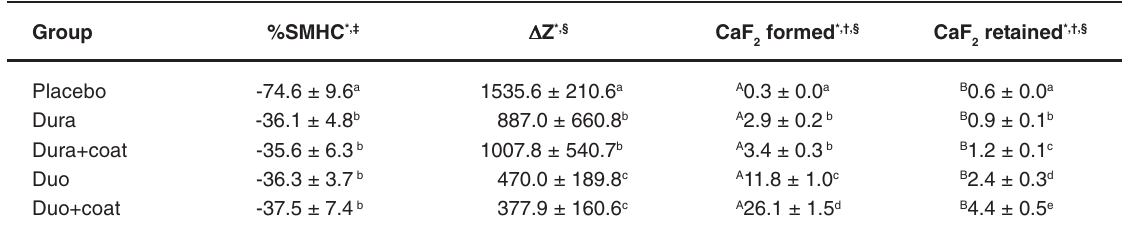
*Different lowercase letters indicate statistically significant differences among the groups. † Different uppercase letters indicate statistically significant differences between CaF § Kruskal-Wallis, p<0.05. TABLE 2- Amount of F (µg) detected in the solutions after pH cycling (mean ± standard error)